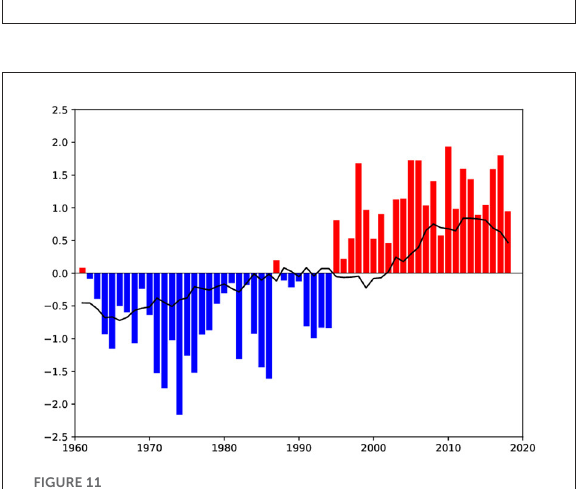
(Li et al., 2017; Liu et al., 2019). In the warm AMO phase,